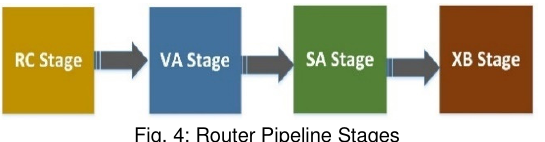
Fig. 4: Router Pipeline Stages